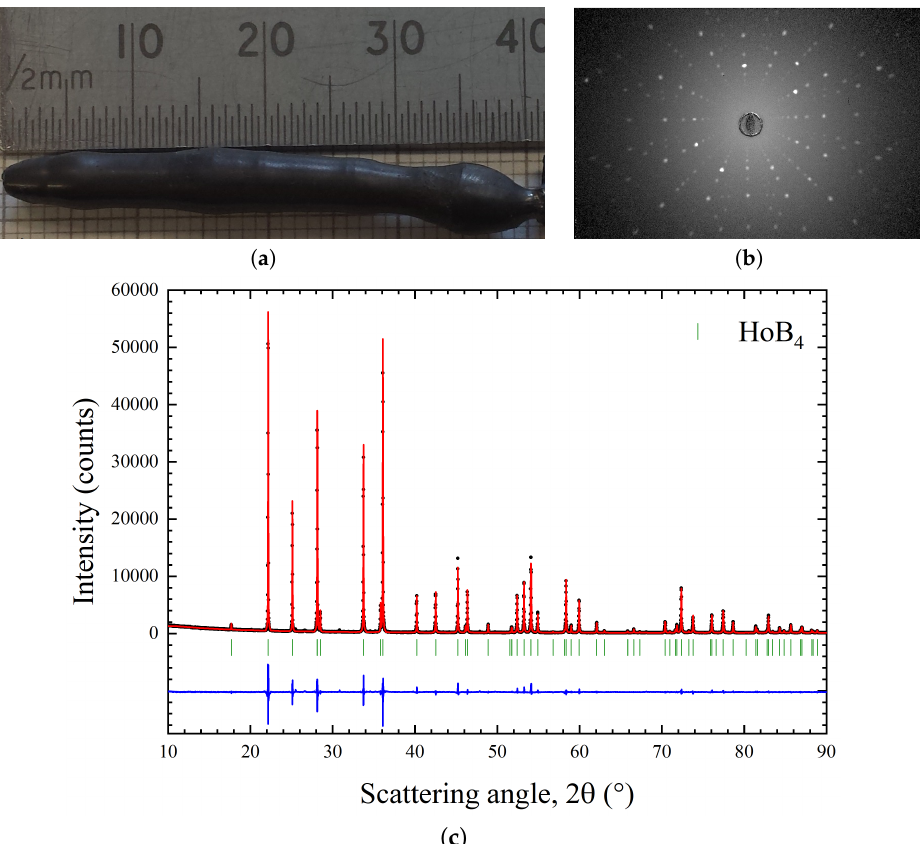
Figure 8. ( a ) Boule of HoB 4 prepared by the floating-zone method in an argon atmosphere at a growth rate of 15 mm/h. ( b ) X-ray Laue back reflection photograph of a crystal of HoB 4 , showing the [001] orientation of an aligned sample used for physical properties measurements. ( c ) Room temperature powder X-ray diffraction pattern of a piece of ground HoB 4 crystal. The experimental profile (black closed circles) and a full profile matching refinement (red solid line) made using the P 4/ mbm tetragonal structure are shown, with the difference given by the blue solid line.